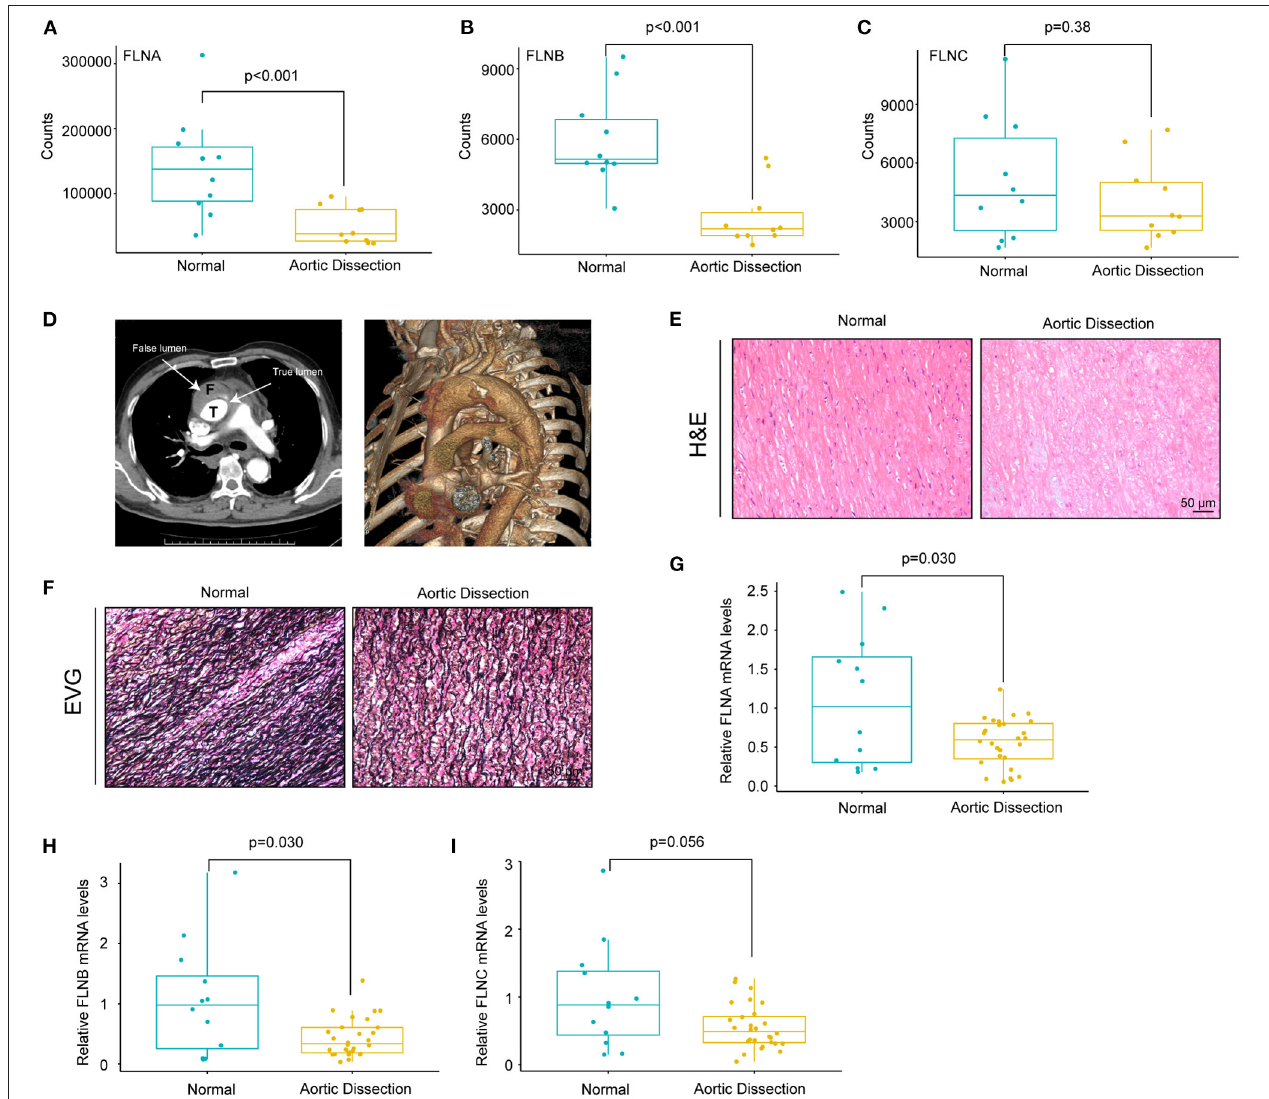
FIGURE 3 | The mRNA levels of FLNA and FLNB were downregulated in human TAAD tissues. (A–C) The expression of FLNA (A) FLNB (B) and FLNC (C) in non-AD and dissected human aortas based on GSE153434 dataset. (D) Representative iterative reconstruction CTA images of TAAD patients, T, true lumen; F, false lumen. (E,F) Representative images of H&E-stained (E) and EVG-stained (F) aortic sections from non-AD and dissected human aortas. (G–I) The relative mRNA levels of FLNA (G) FLNB (H) and FLNC (I) in the aortas of humans from normal donors ( n = 14) and AD ( n = 33)